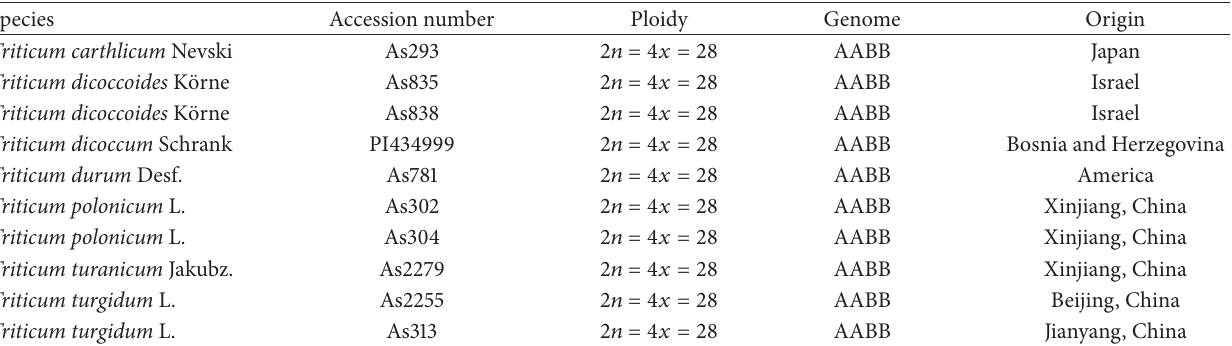
Table 1: Materials used in this